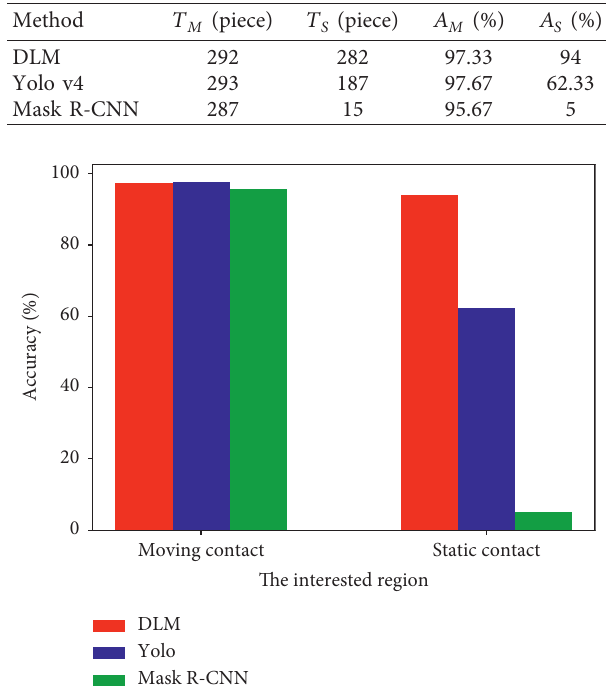
Figure 15: Plot of DLM positioning accuracy. Table 3: Comparison of positioning accuracy.